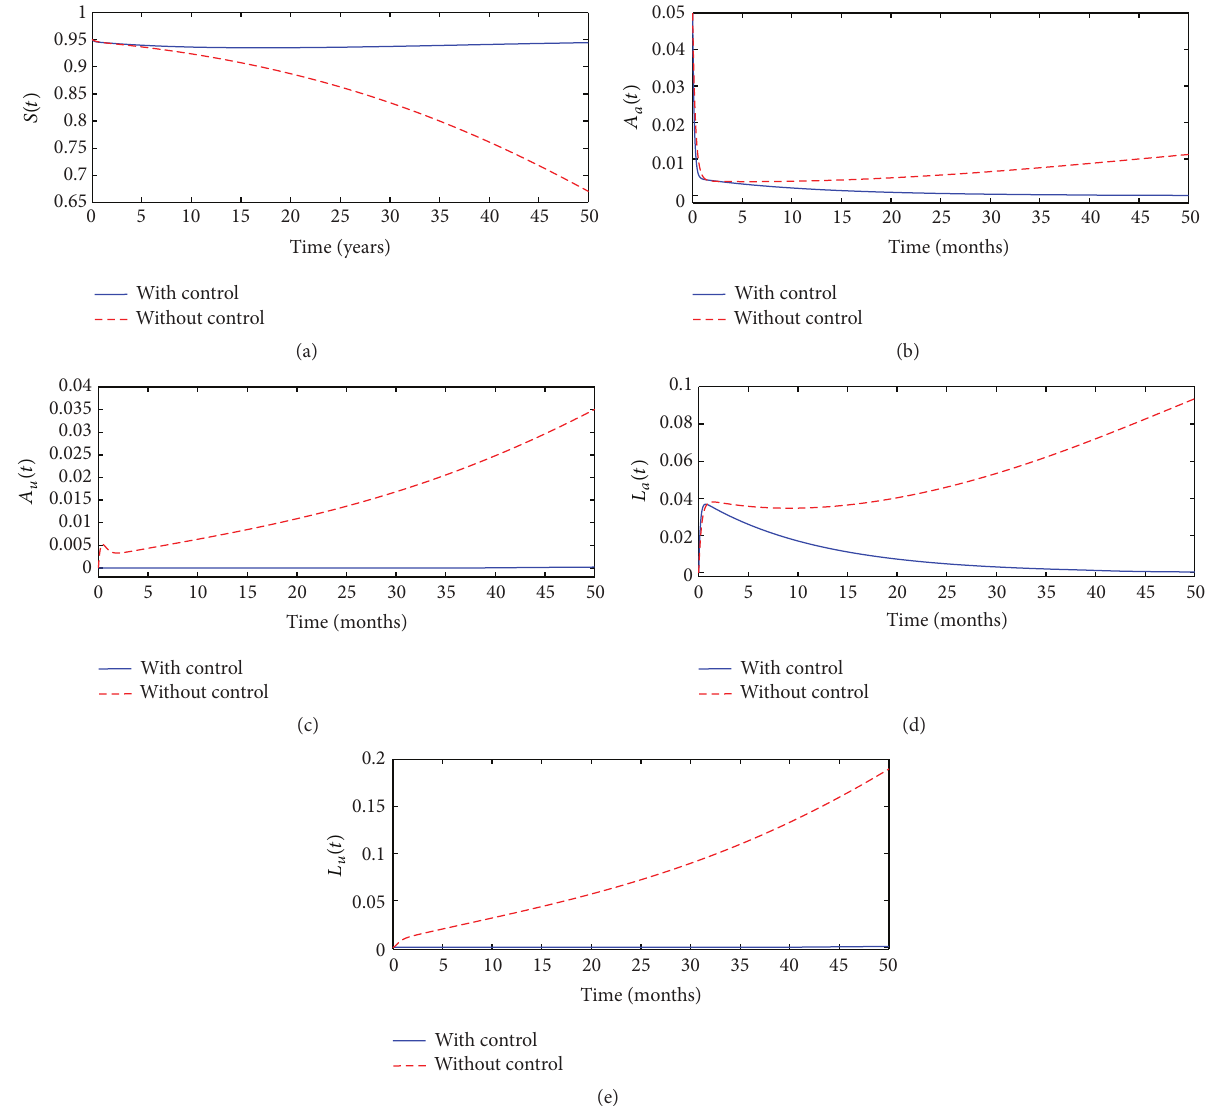
Figure 4: Graphs of the numerical solutions of the optimality system, showing propagation of (a) susceptibles 𝑆 , (b) infected individuals with acute HSV-2 and also under antiviral treatment 𝐴 𝑎 , (c) infected individuals with latent HSV-2 after undergoing successful antiviral treatment 𝐿 𝑎 , (d) infected individuals with acute HSV-2 and not under antiviral treatment after quitting before completion individuals with latent HSV-2 after undergoing natural healing 𝐿 𝑢 , over a period of 50